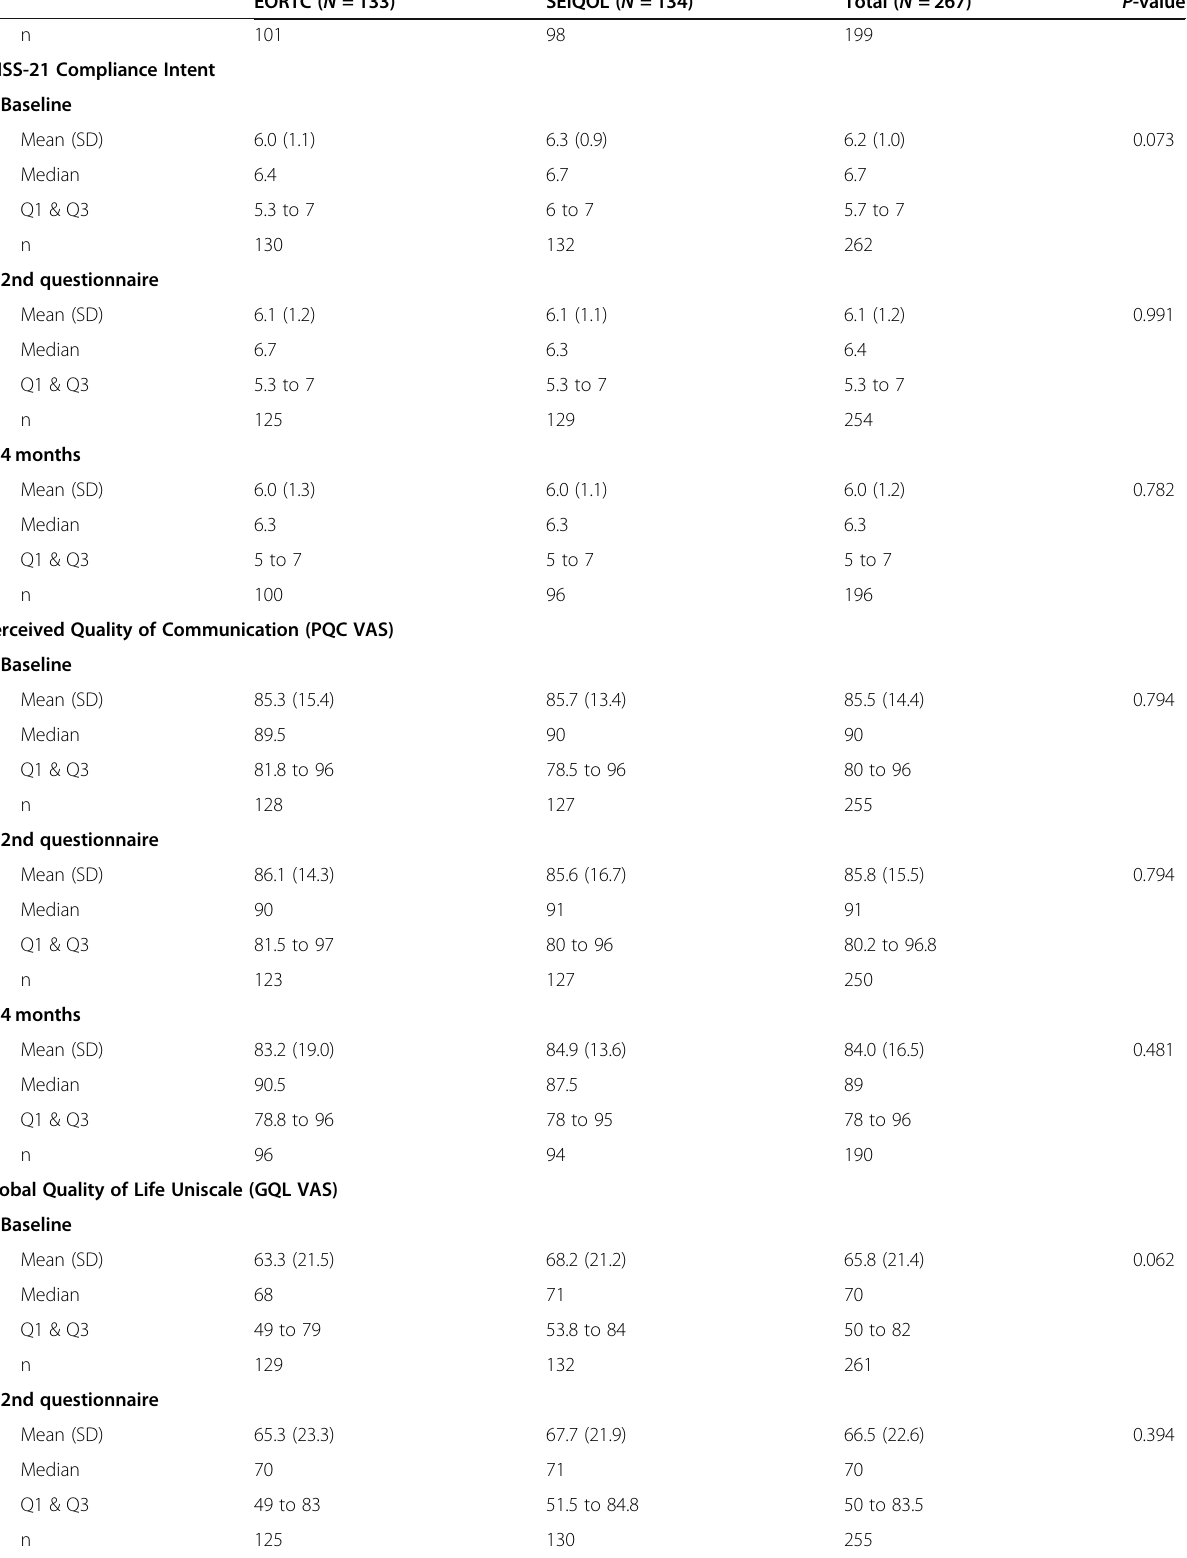
Table 2 Outcomes a over time for analyzed patients